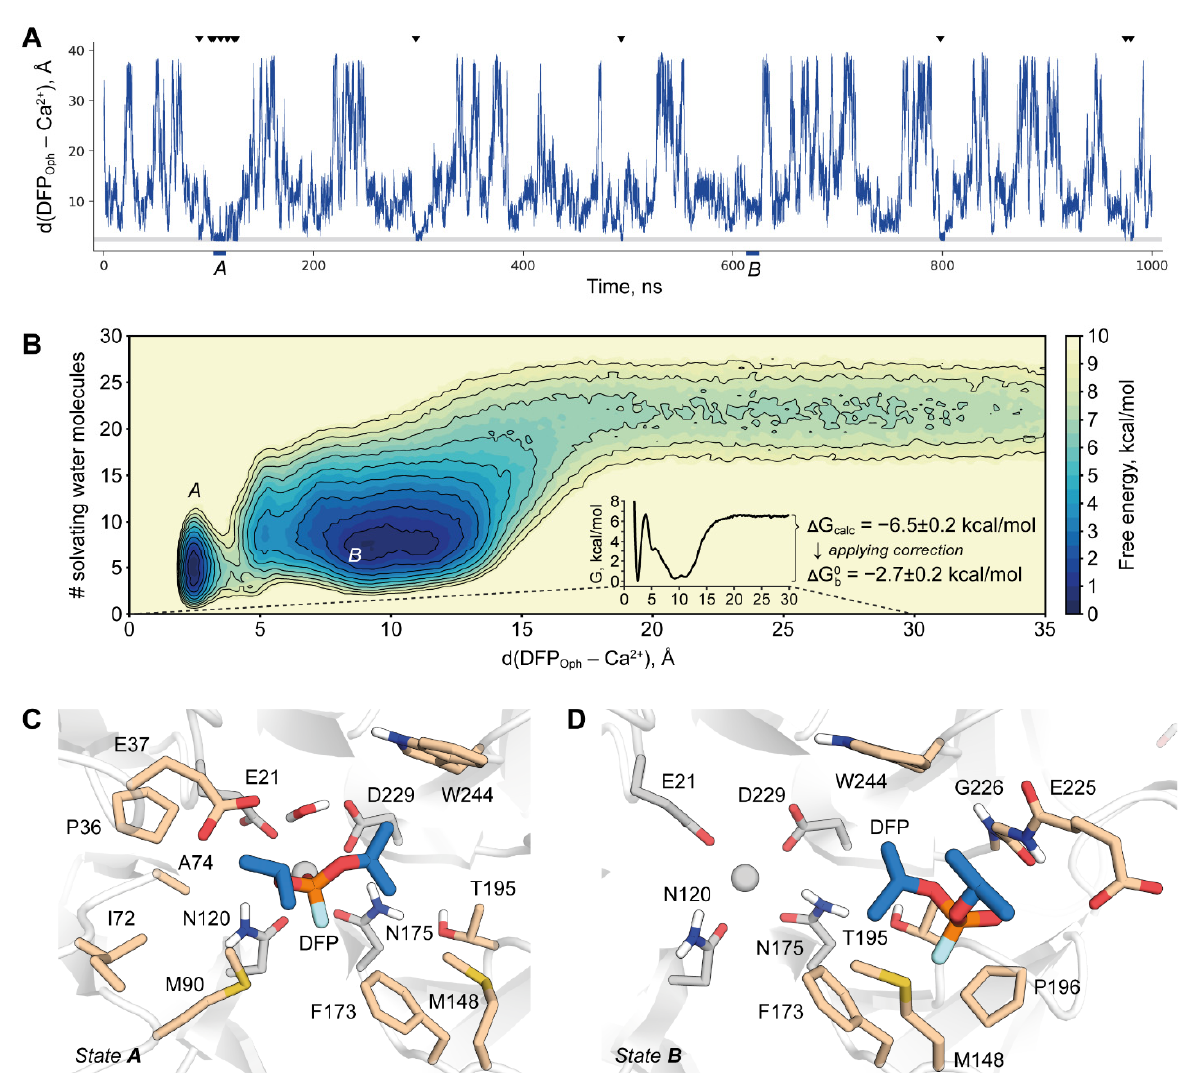
Figure 4. Funnel metadynamics simulation of DFPase-DFP interaction upon binding. ( A ) Time progression of the simulation. Shaded gray area corresponds to Ca 2+ coordination by phosphoryl oxygen. Black arrows indicate reaching the pre-reaction state. Time ranges used to extract frames of binding modes of interest are marked with capital letters. ( B ) Free energy profile of substrate binding. Minima corresponding to stable binding modes are marked with capital letters. ( C ) Pre-reaction state reached in the simulation. ( D ) The alternative stable state reached in the simulation. DFP carbon atoms are shown in blue, catalytic residues are colored gray and hydrophobic residues forming binding pockets for both states are shown in wheat. Non-polar hydrogen atoms are omitted for clarity.